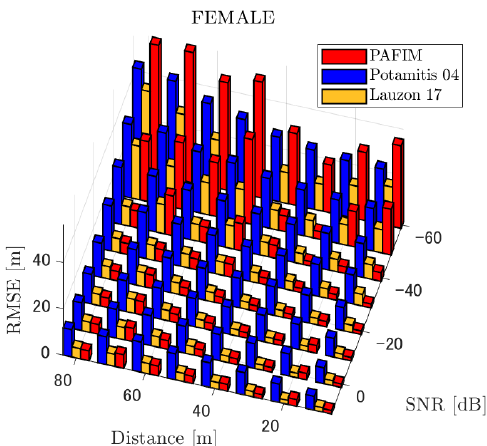
Figure 10. RMSE of tracking a sound source moving in a circle emitting female voice.